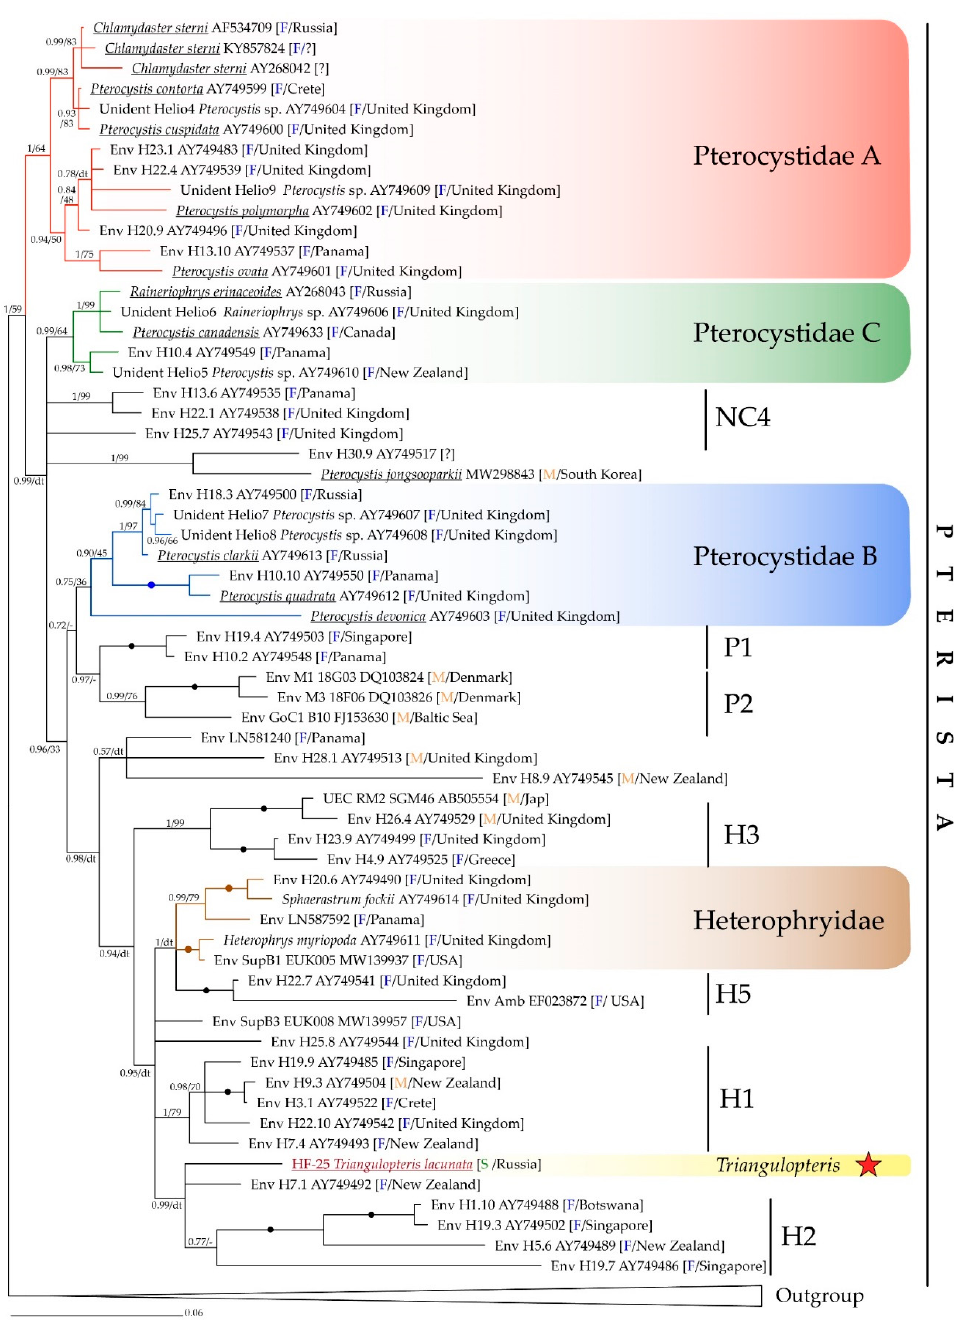
Figure 6. Phylogenetic tree generated from Bayesian analysis based on SSU rRNA gene sequences from 79 centrohelids. The sequence from this study is highlighted in red and marked with a star. Bayesian posterior probabilities (BPP) and Maximum Likelihood (ML, TN+F+R6 model) bootstrap values are indicated on branches (values >0.5/>30 are shown); filled circles indicate values of BPP = 1.00 and ML bootstrap = 100%; dt—different topology. Abbreviations: F—freshwater